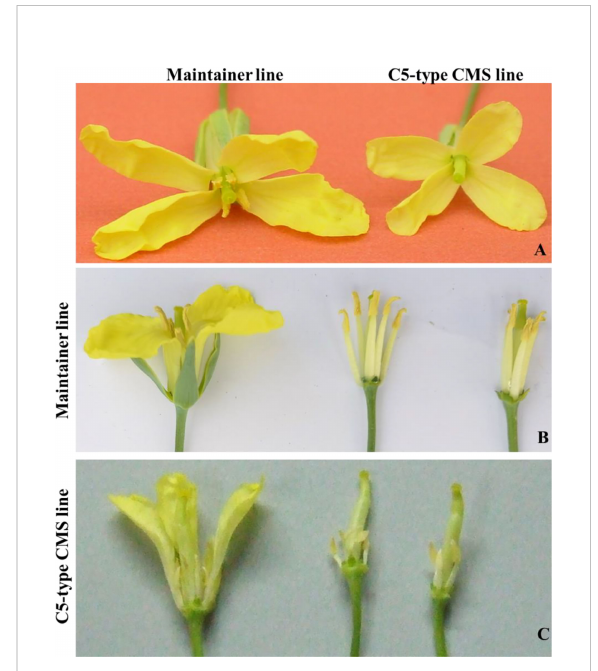
FIGURE 1 Flower morphology of maintainer lines and C5-type CMS lines. (A) Intact fl owers of the C5-type CMS line and maintainer lines. (B) Partially dissected maintainer fl ower. (C) Partially dissected C5-type CMS fl ower.